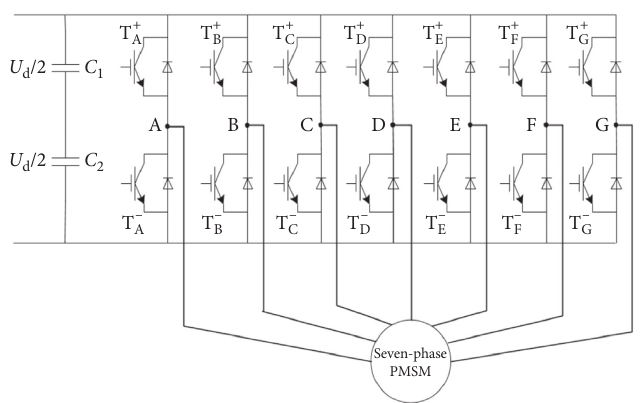
Figure 1: Main circuit of seven-phase bridge